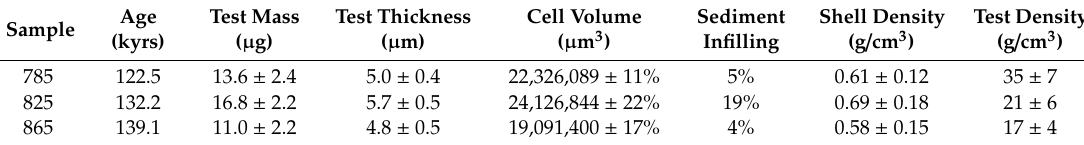
Table 1. Average biometric data of foraminifera from weighing and µ CT (computed tomography) analysis. Test thickness is the ratio of calcite volume to calcite surface, and shell and test density are the ratio of the average shell weight to test and shell volume, respectively (see Section 3.3 for details). Sediment infilling is the specimen’s internal volume percentage occupied by sediment